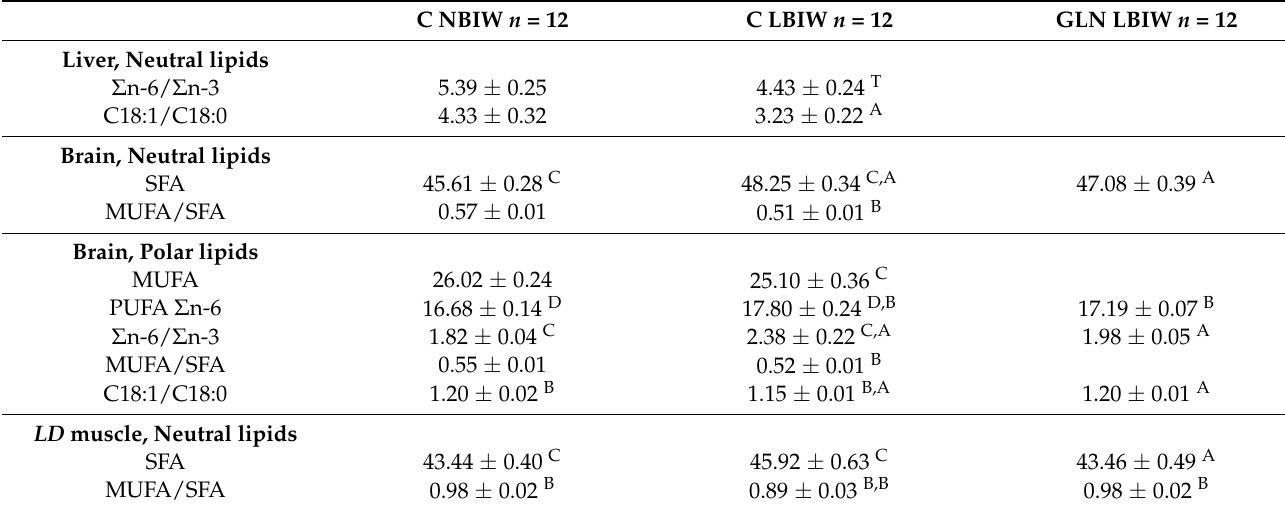
Differences between control LBIW and NBIW newborns were found in the neutral and polar lipid fractions of the brain and the neutral fraction of the liver and muscle (Table 4), but not between treated LBIW and NBIW ones. Unsaturation indexes (MUFA/SFA or